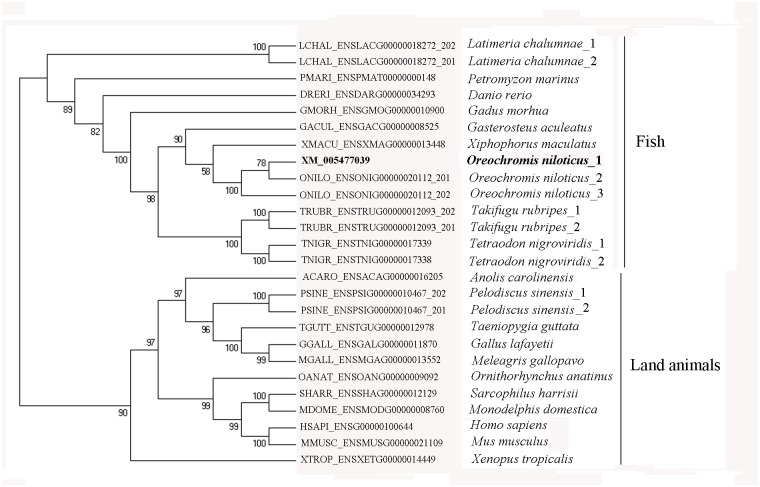
The unrooted phylogenetic trees constructed by using CDS sequences of HIF1α genes showing separating of the fish species from the land animals.